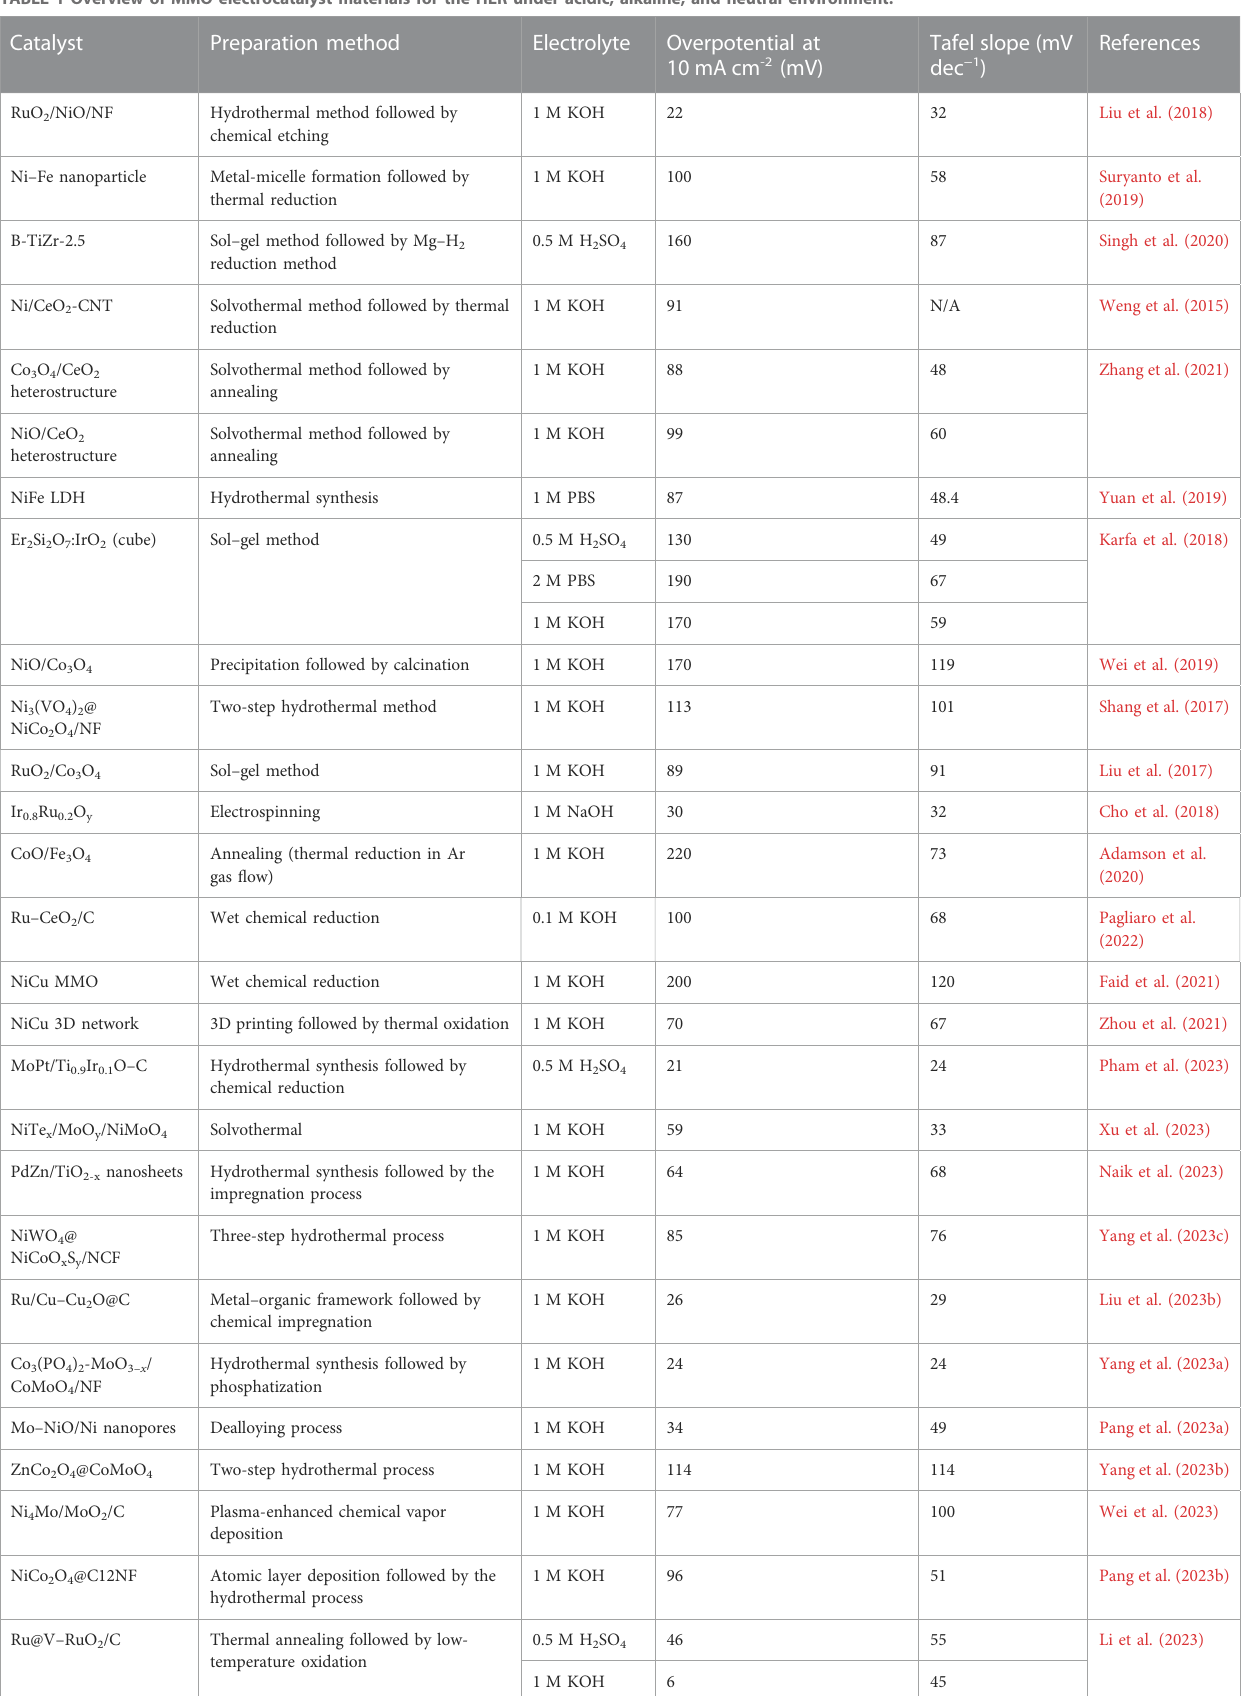
TABLE 1 Overview of MMO electrocatalyst materials for the HER under acidic, alkaline, and neutral environment.